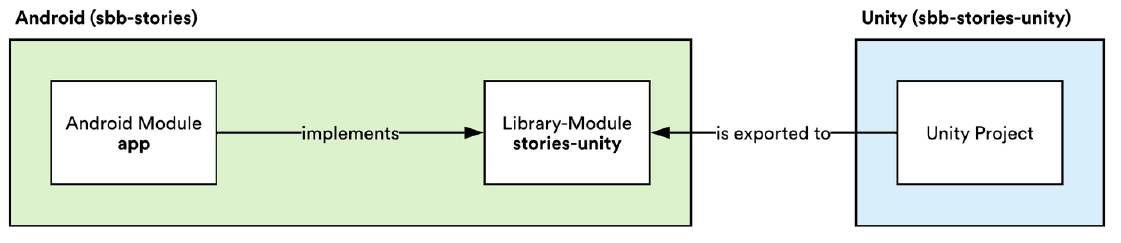
Figure 4. Implementation